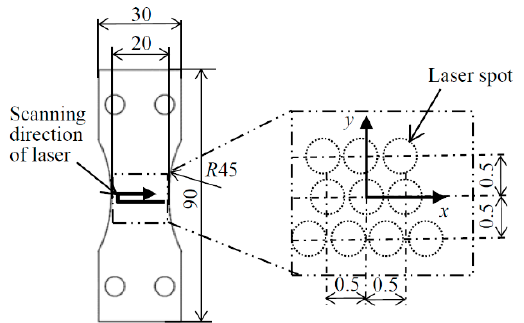
Figure 4. Schematic diagram of specimen D treated by laser cavitation peening and the coordi- nates for residual stress measurement. for residual stress